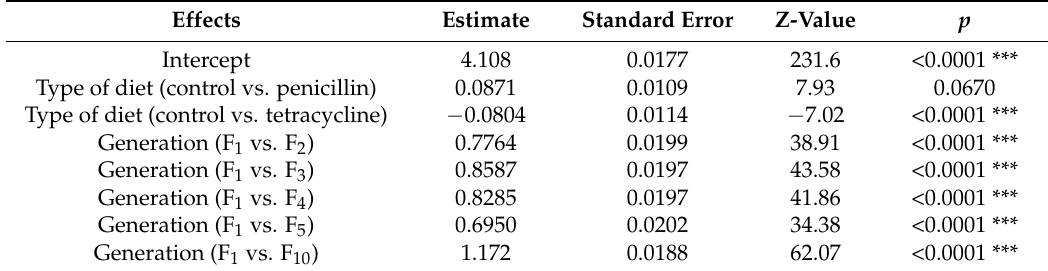
Table A2. Results of generalized linear model evaluating the relationship between CBB total population and type of diet (control, penicillin 0.1%, and tetracycline 0.1%) and between generations for CBB on diet with tetracycline. *** p < 0.001; ** p < 0.01; * p < 0.05; p <